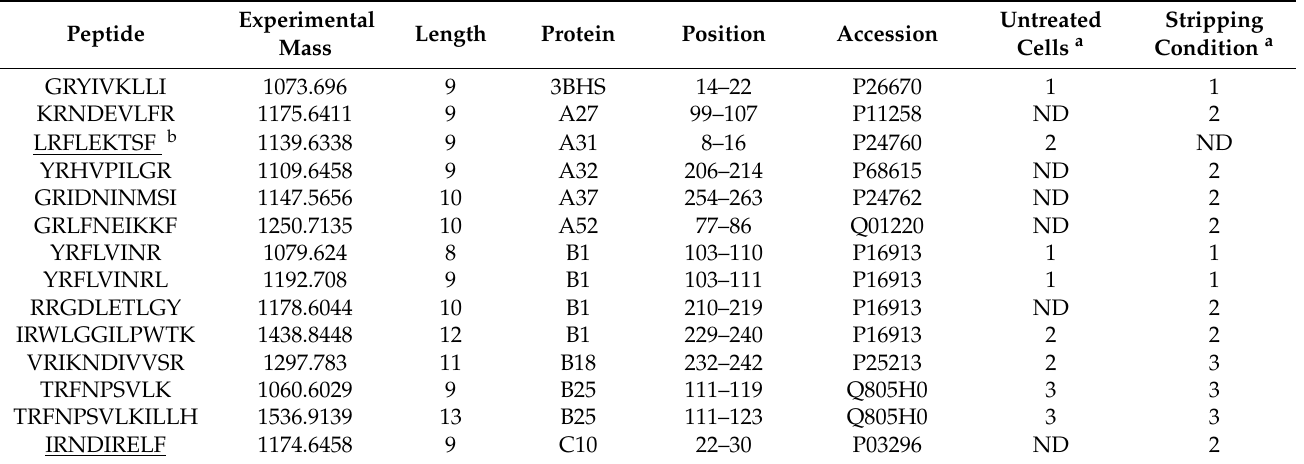
Table 1. Summary of the HLA-B*27:05 ligands detected by MS/MS analysis in VACV-infected